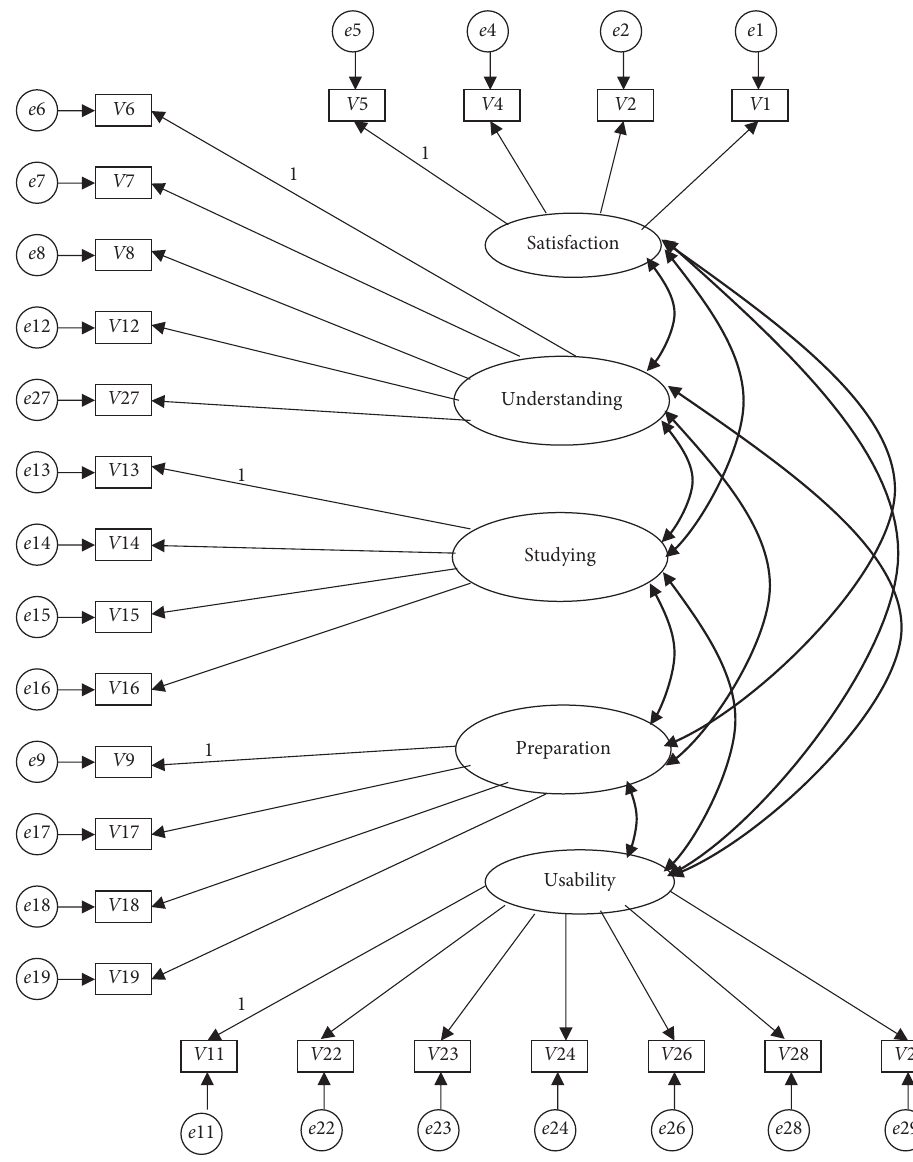
Figure 2: First-order five-factor construct (model